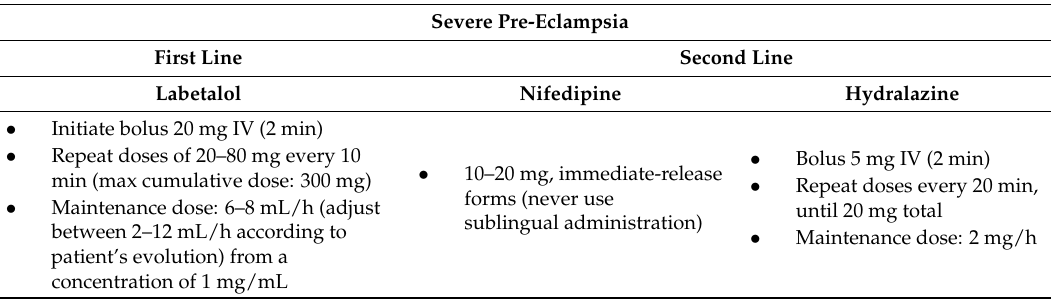
Table 4. Proposed pharmacotherapy for severe pre-eclampsia.